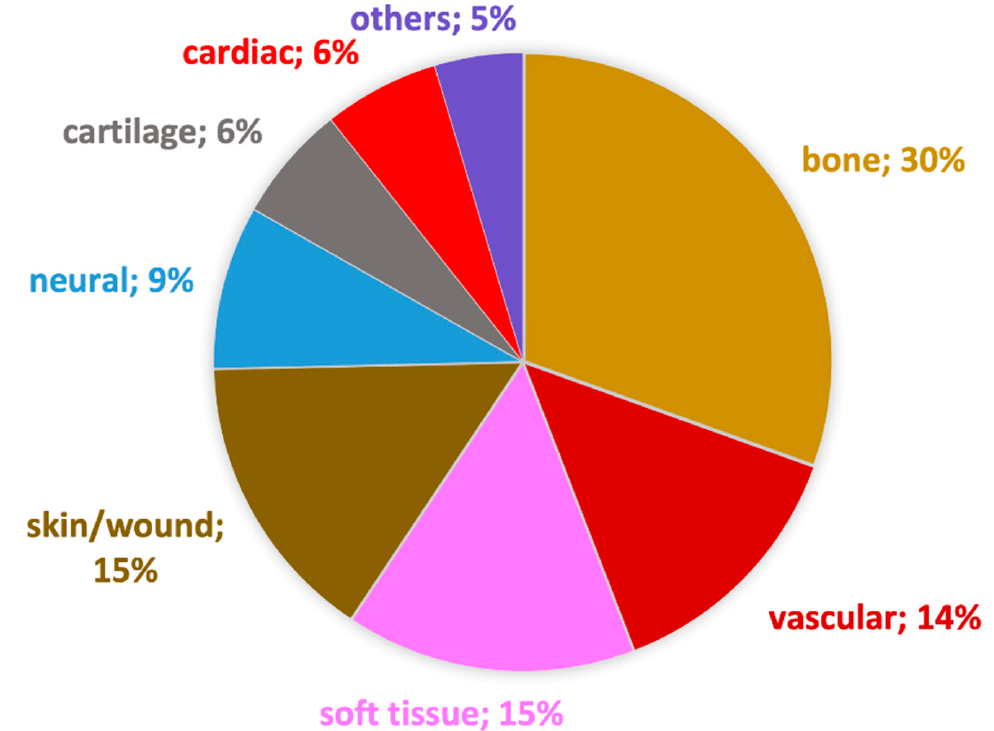
Figure 5. Major application areas of electrospun nanofibers developed for tissue engineering according to research realized in the PubMed database, until October 2022. The keywords used in the field Title/Abstract were: “tissue engineering” and “electrospinning” or “electrospun” and the following tissues or organs: “bone”, “vascular” or “vessels”, “soft tissue” or “tendon” or “valve” or “muscle”, “skin” or “wound healing” or “wound dressing”, “neural” or “nervous”, “cartilage” or “trachea”, “heart” or “cardiac”, “suture”, “bladder”, “corneal”, “liver” or “hepatic”, “incontinence”, “conjunctival”.